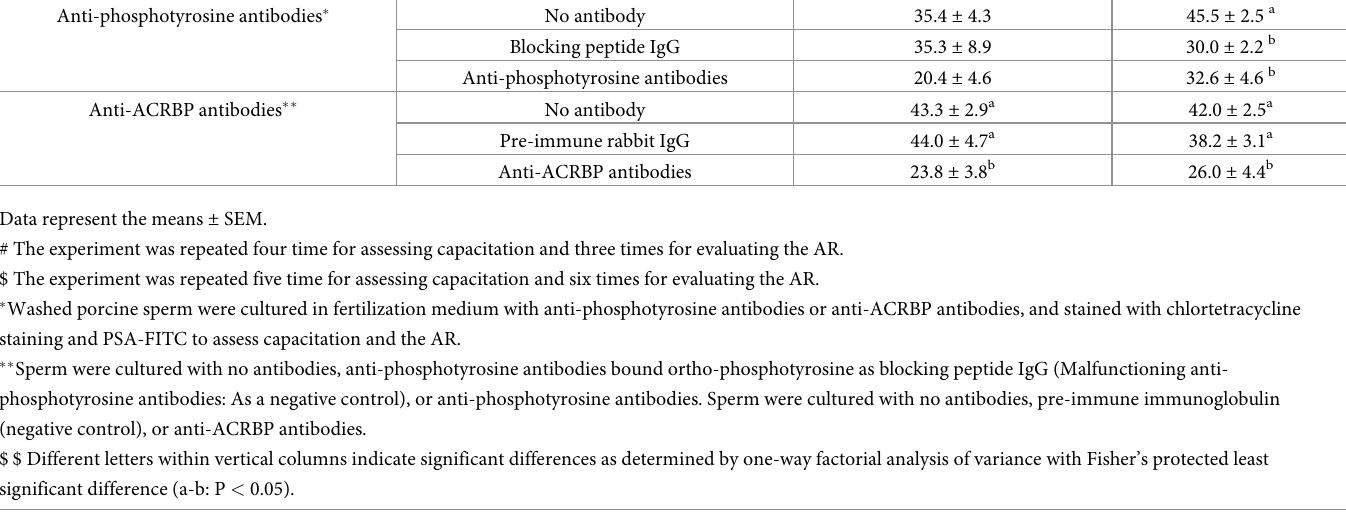
Table 3. Influence of anti-phosphotyrosine # and anti-ACRBP antibodies $ upon sperm capacitation and the AR $$ . Experimental